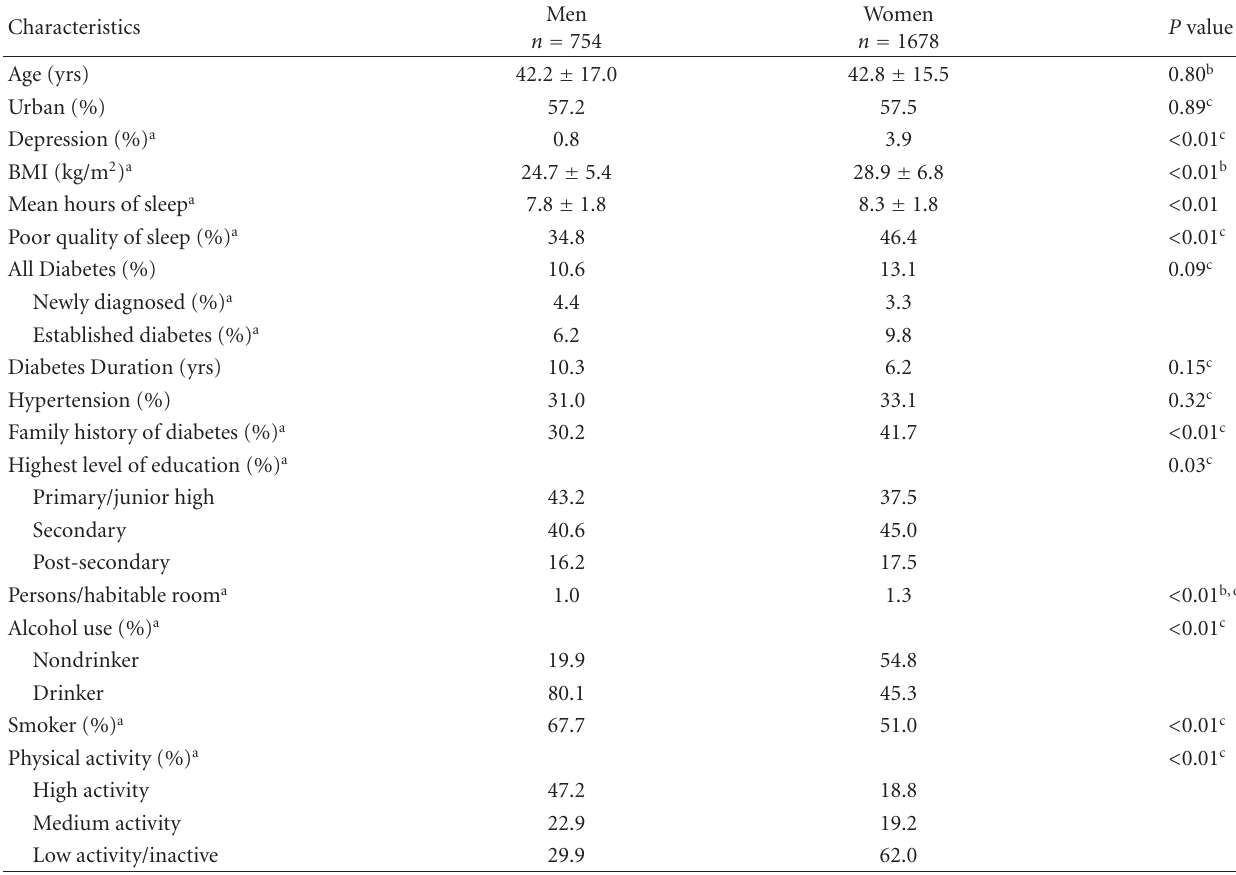
Table 1: Characteristics of the study population by